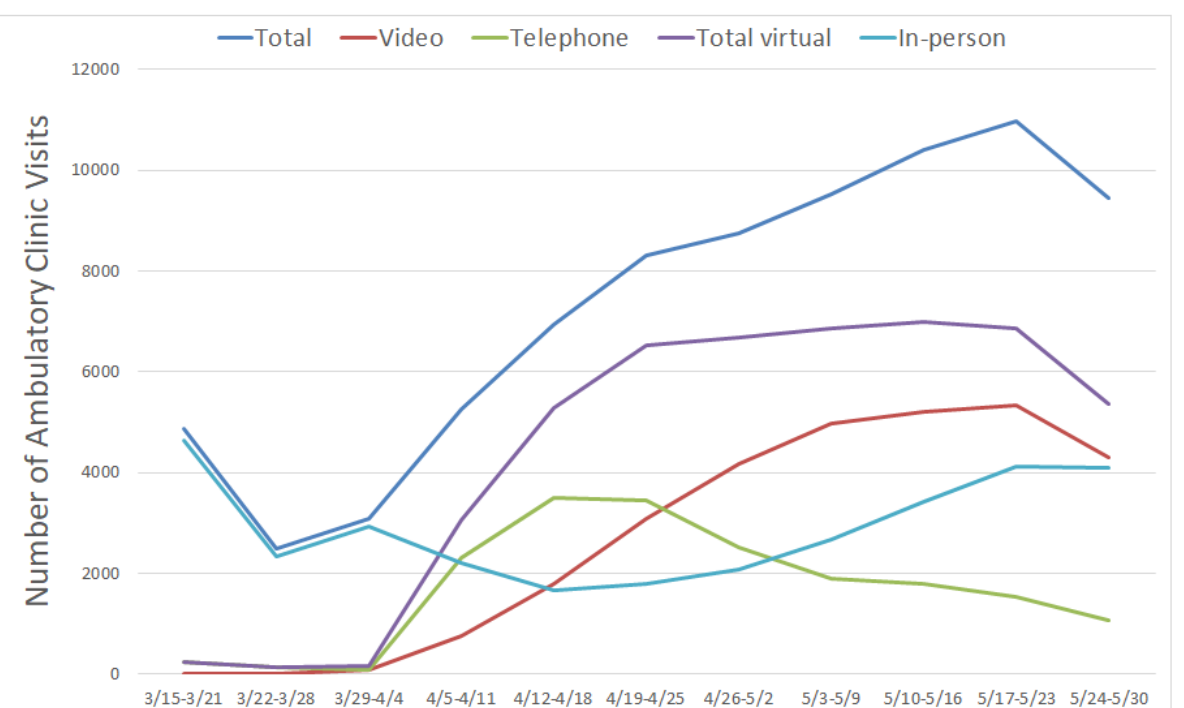
Figure 1. Ambulatory visit volumes and types from March 15 to May 31, 2020. Note: all visit volumes decreased during the final week of May due to Memorial Day clinic